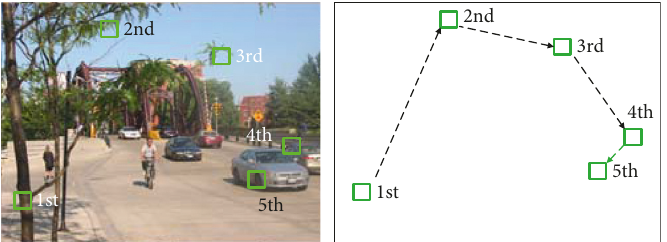
Figure 1: Selection of a sequence of points on a single picture in the PPGP system [13]. The numbers shown on the image mean the orders of clicks.